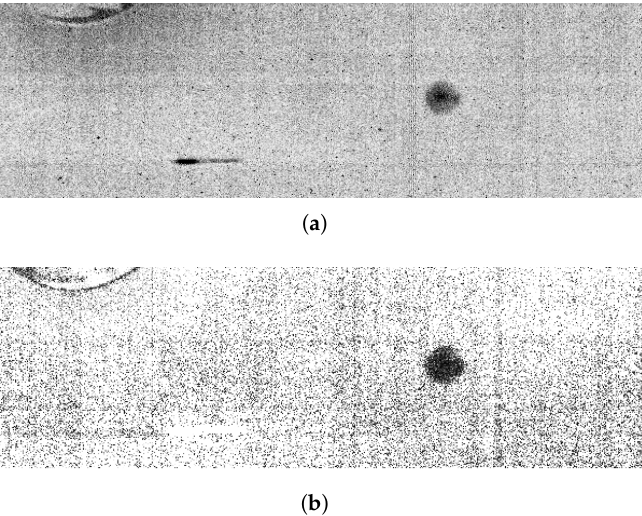
Figure 9. The amplitude ( a ) and phase image ( b ) of area I for a frequency range of 20kHz to 30kHz and a periodicity of τ = 5s. The dark spot in both images corresponds to the damaged